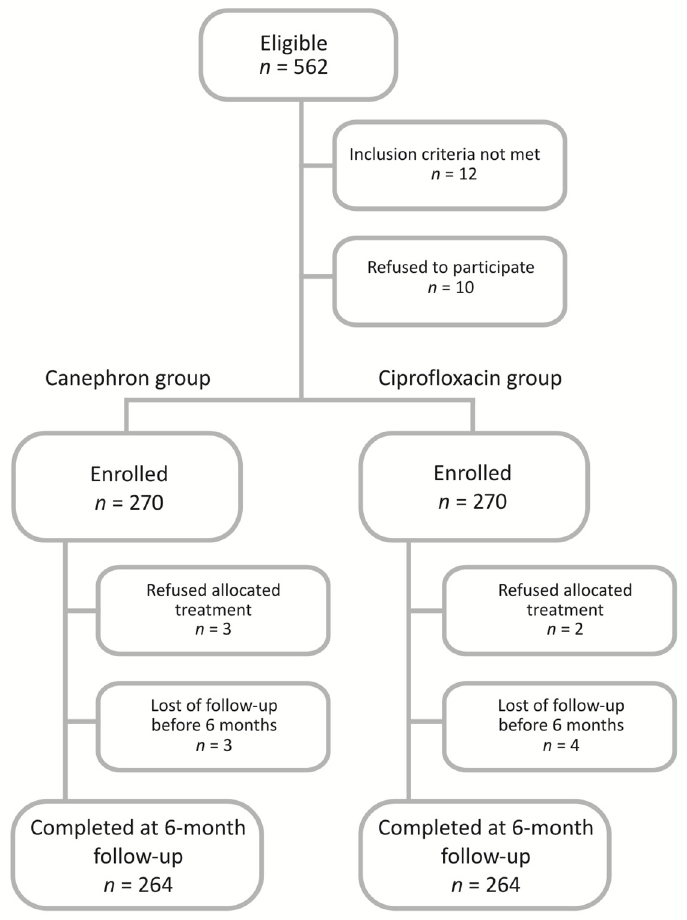
Figure 1. Flowchart of the participants in the study.